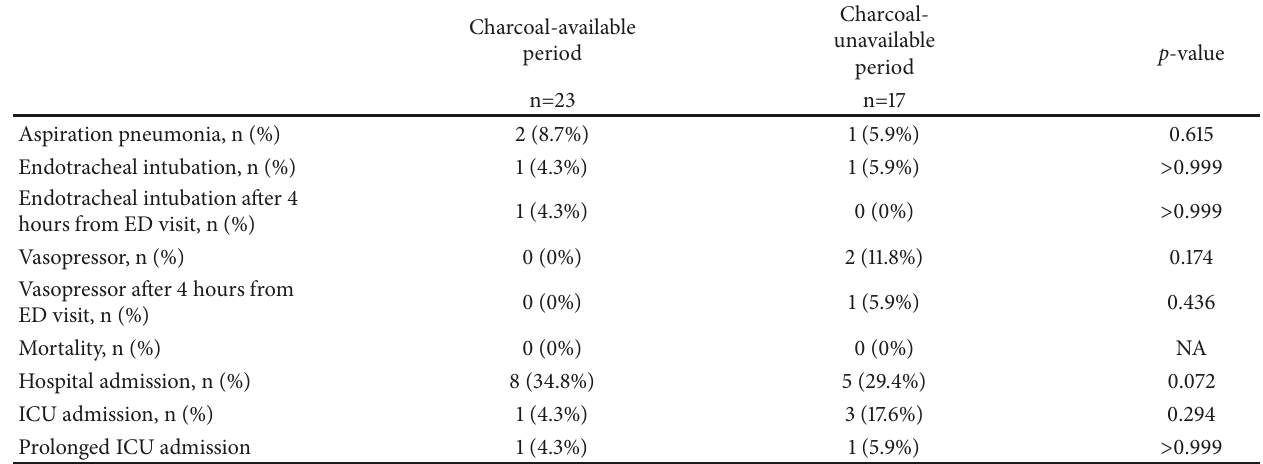
Table 7: Clinical outcomes of patients who may benefit from activated charcoal use ∗ .